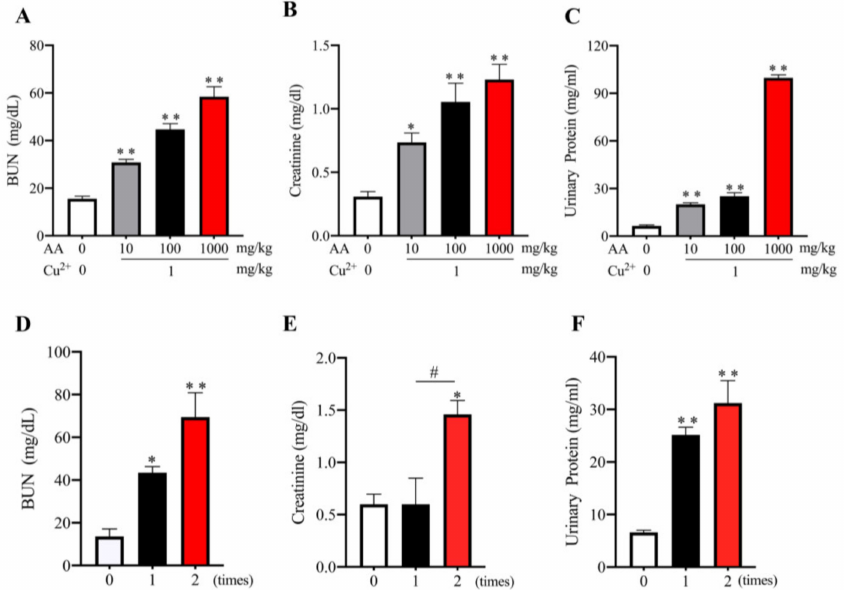
Figure 4. Dose- and time-effects of AA and Cu 2+ on kidney functions. Mice were administered with the indicated concentrations of AA together with or without 1 mg/kg Cu 2+ via oral gavage once a day ( A – C ) or with 100 mg/kg AA plus 1 mg/kg Cu 2+ once or twice per day for six days ( D – F ). The level of BUN, creatinine and urinary proteins were measured. Data shown are mean ± SE ( n = 4; * p < 0.05; ** p < 0.01 vs. control; # p <